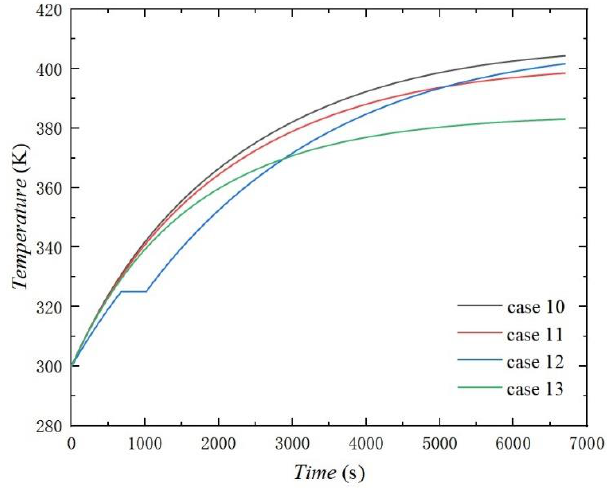
Figure 21. Temperature of accessory 1 when the baffle and accessory were thermally protected.